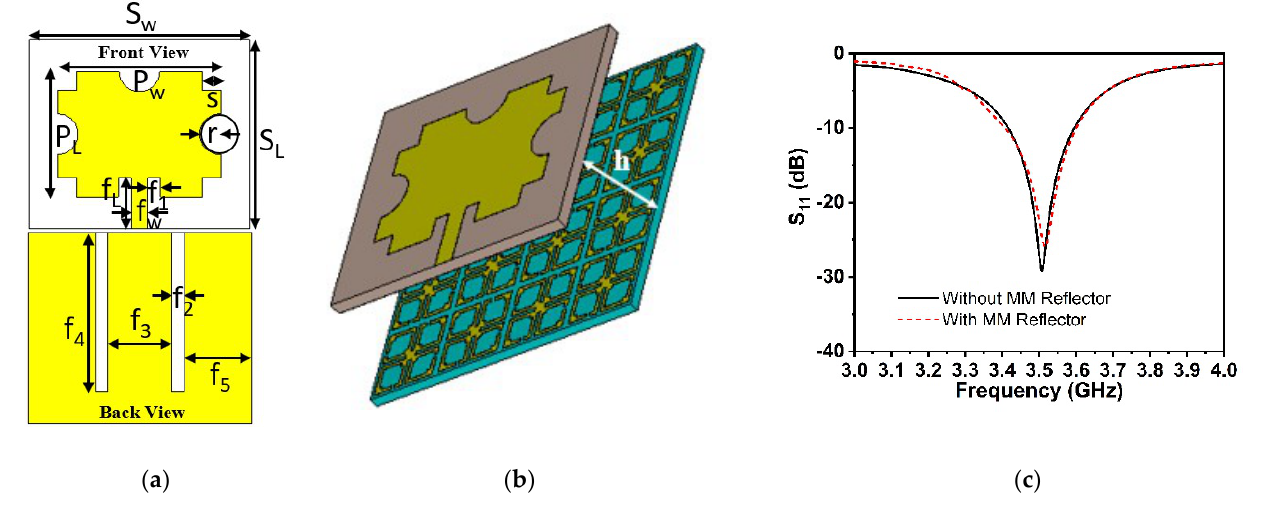
Figure 16. ( a ) Proposed antenna geometry. ( b ) Antenna with a developed MM reflector. ( c ) Reflection coefficient of the antenna with and without MM reflector.